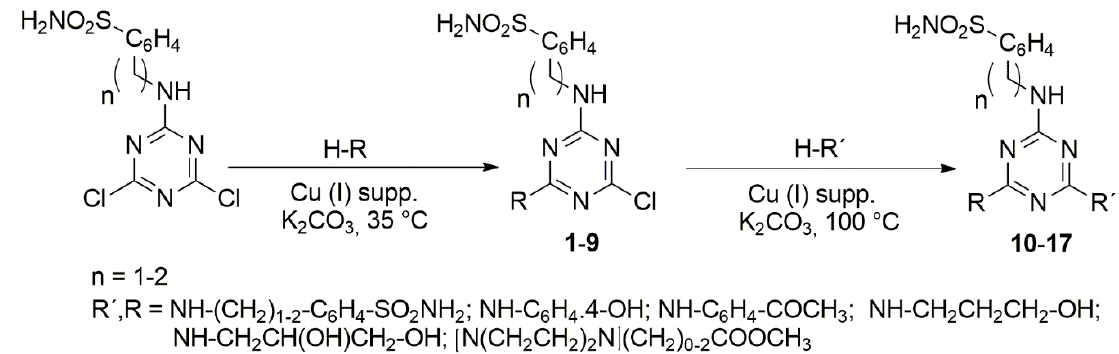
Table 1. Results of uncatalyzed and catalyzed syntheses of di- and trisubstituted 1,3,5-triazine derivatives including one-pot synthesis of trisubstituted 1,3,5-triazine derivatives.